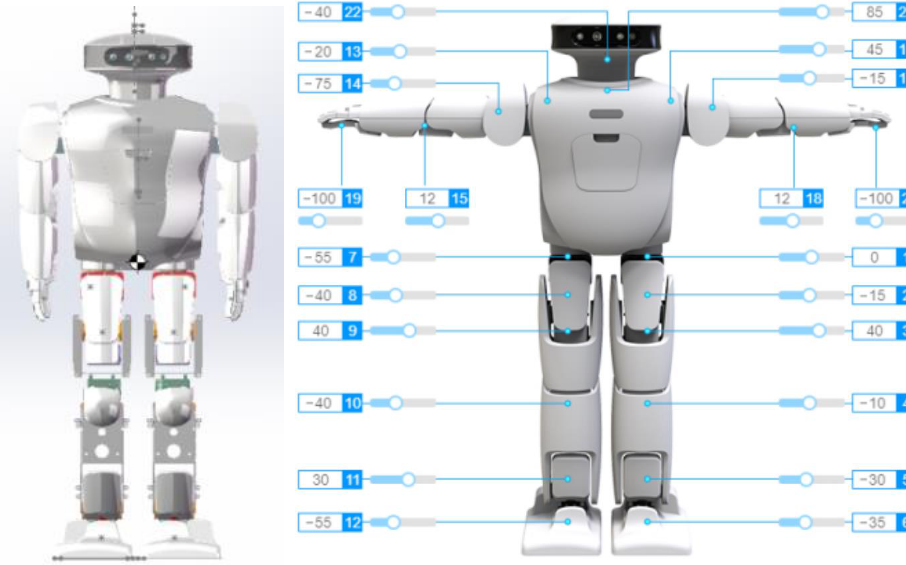
Figure 2. Control block diagram of spring compensation.